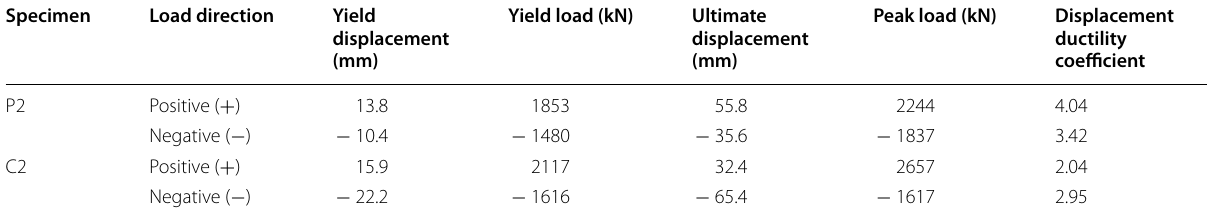
Table 3 Statistics of the low-reversed cyclic loading results.